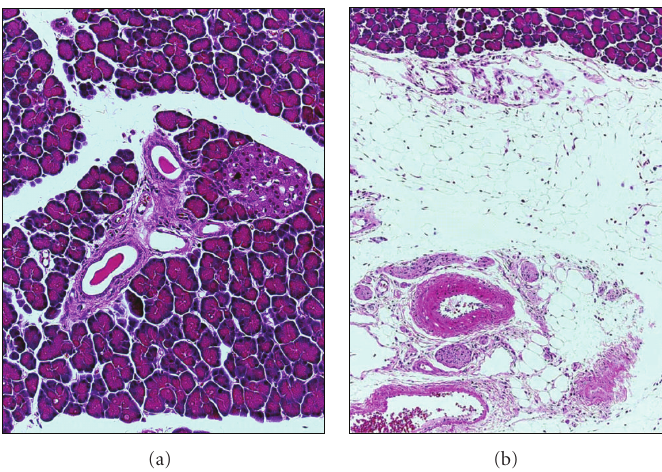
Figure 3: Representative photomicrographs of the pancreas after complete ligation of the main pancreatic duct. Common bile duct was ligated proximal to the pancreas near the liver, and a cannula was inserted above the ligature, and the bile was introduced into the duodenum via cannula so as to prevent obstructive jaundice. The biliopancreatic duct was completely ligated at its entrance into the duodenum. (a) On day 7 after the ligation, pancreatic fibrosis was observed only around the slightly dilated duct. (b) On day 14 after the ligation, pancreatic parenchymal tissues were replaced by fatty tissue without fibrosis. (Hematoxylin and eosin staining, original magnification ×